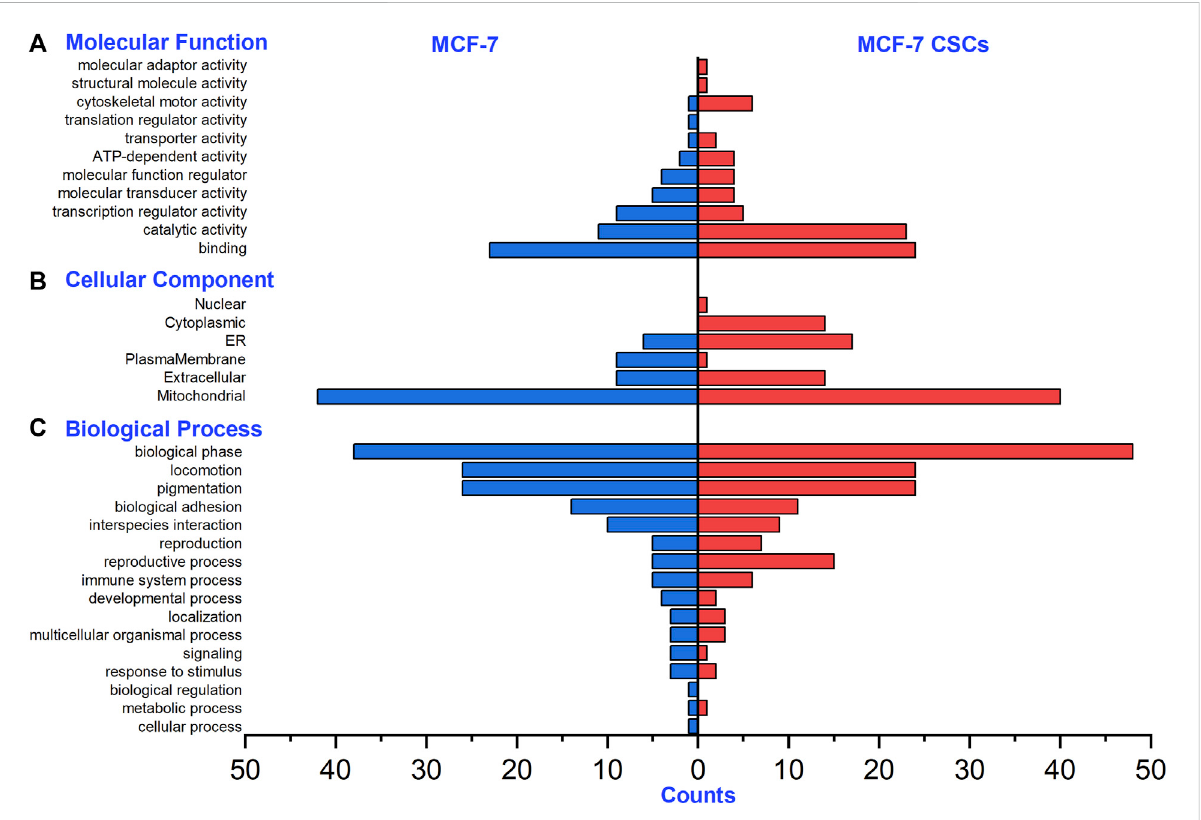
FIGURE 5 Gene ontology analysis of N-glycoproteins with Neu5Gc identi fi ed from MCF-7 and MCF-7 CSCs. (A) Molecular functions, (B) cellular components, (C) biological processes.